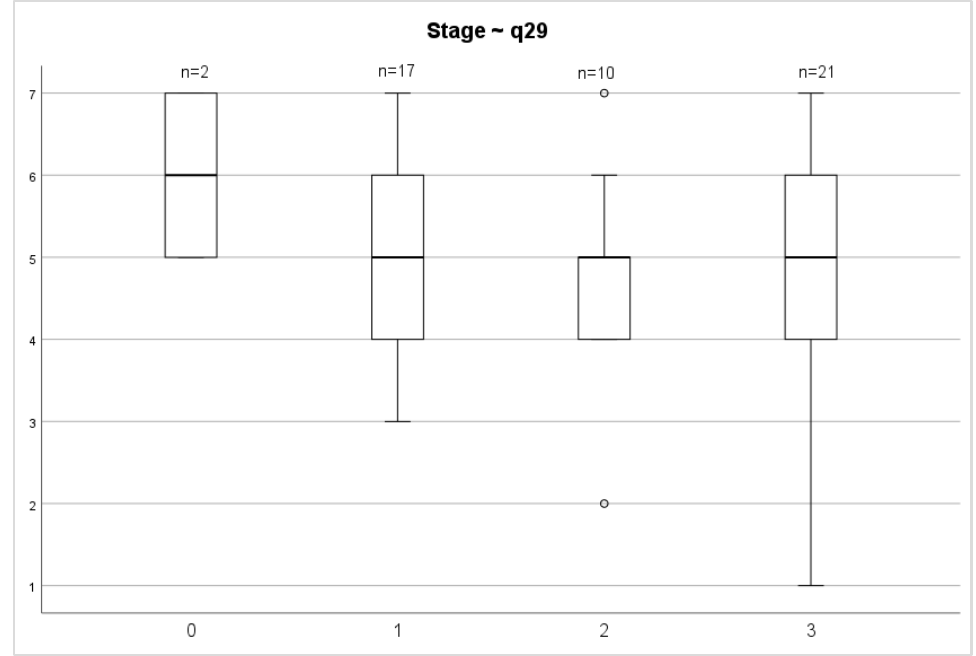
Figure 5. QLQ — CR29 questionnaire outcomes 72 months after surgery. Evaluating the QoL 72 months after surgery between stages of both overall health status and overall QoL scores, we did not find any significant differences ( p = 0.687; p = 0.457) (Figures 6 and 7).